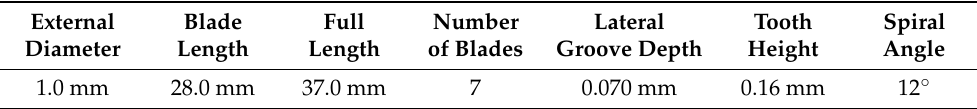
Table 2. Geometric parameters of the